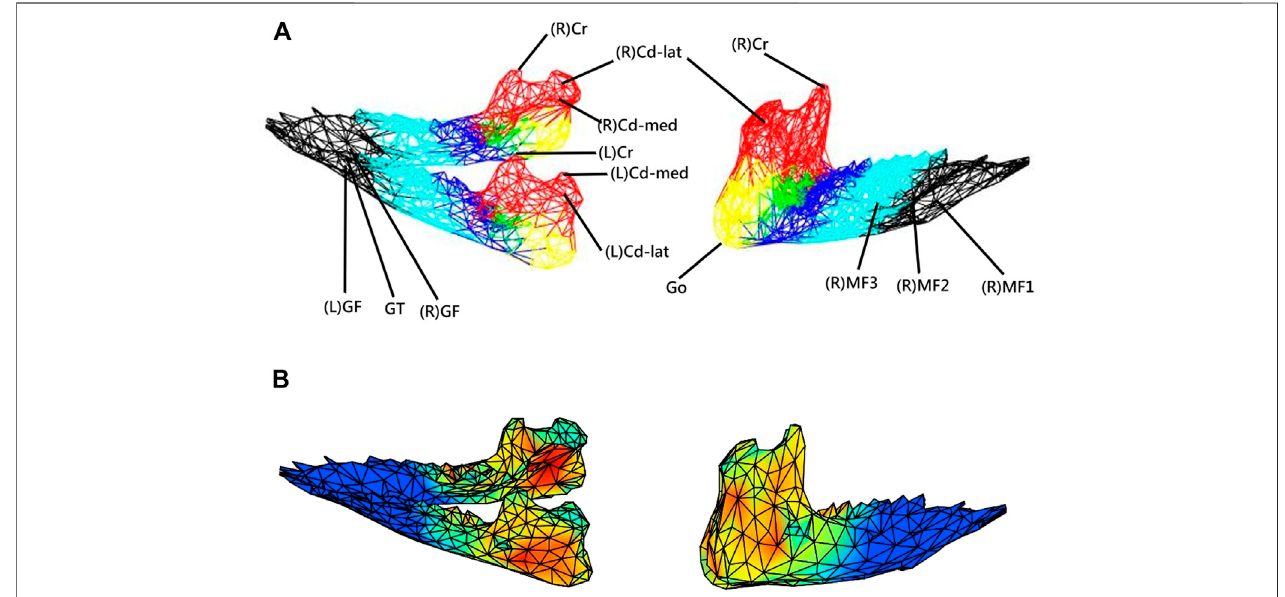
FIGURE 1 | (A) Three-dimensional (3D) model of the mandible indicating 17 anatomical landmarks and six anatomical parts (regions) selected to indicate the distribution of the morphological changes of the mandible during growth, namely condyle (red), posterior ramus (yellow), anterior ramus (green), posterior corpus (dark blue), middle corpus (light blue), and anterior corpus (black). (B) Each mandible at each measurement instance was reconstructed from CBCT data and described by a model of a 3D mesh of vertices forming about 653 triangular elements. With the subject-speci fi c model, the rates of morphological changes (growth rates) were shown with different colors as a color map on the model.